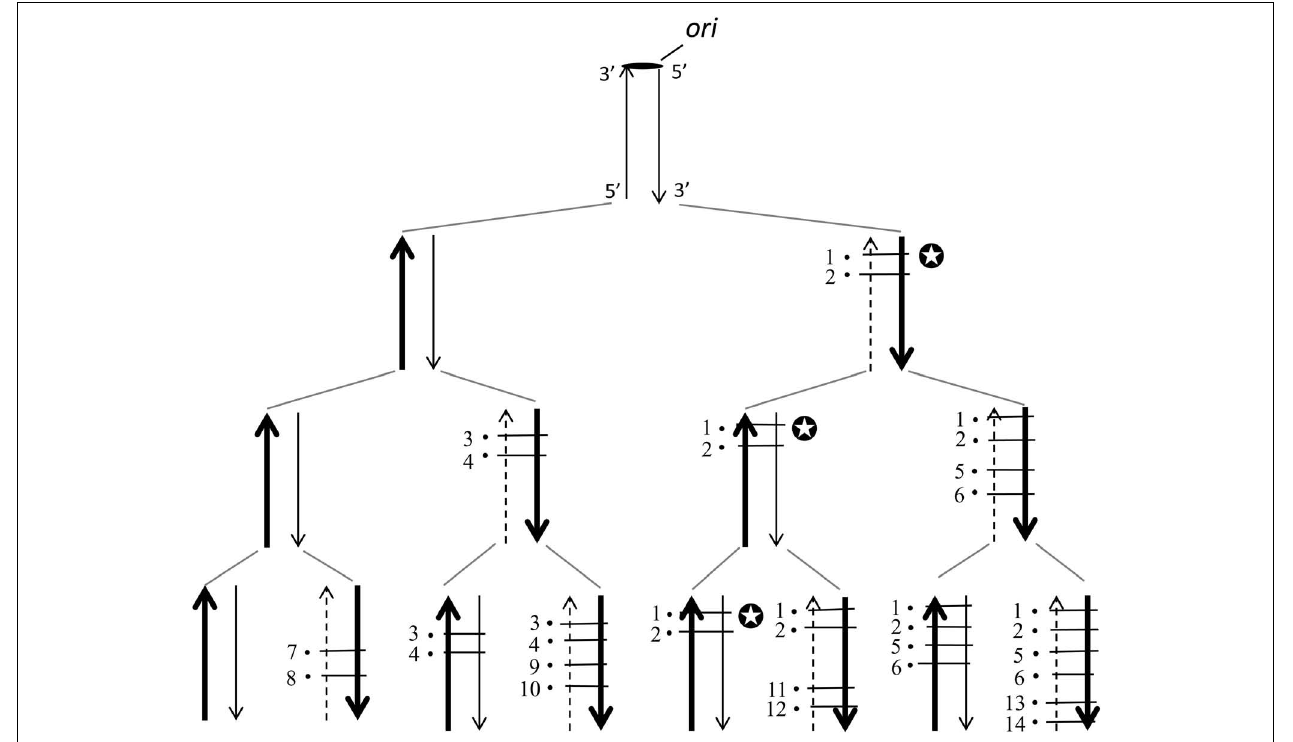
FIGURE 1 |The distribution of mutations according to the deterministic disparity model of a linear DNA is shown. A broad arrow indicates a template DNA strand, a thin arrow indicates a newly synthesized leading strand and a dashed thin arrow indicates a newly synthesized lagging strand. The black circle with a short bar crossing strands indicates a point mutation.